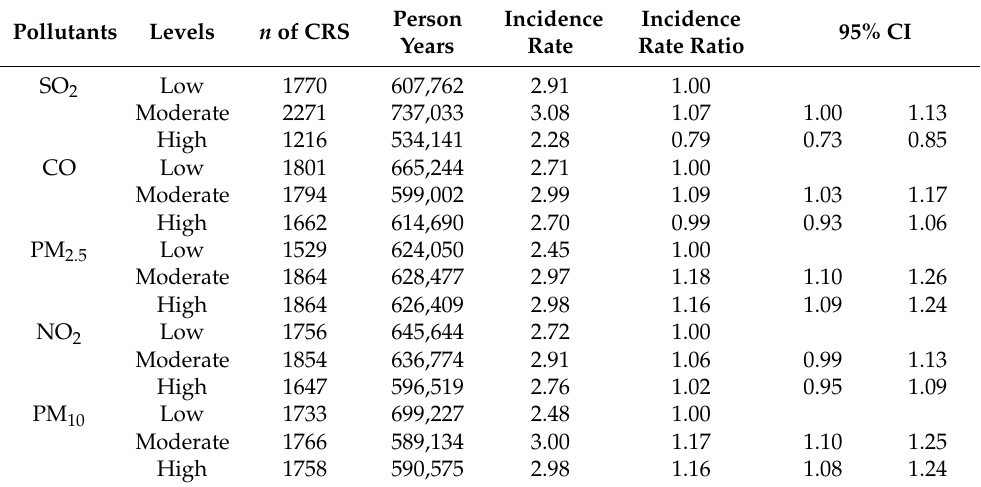
Person Incidence Incidence 95% CI Years Rate Rate Ratio